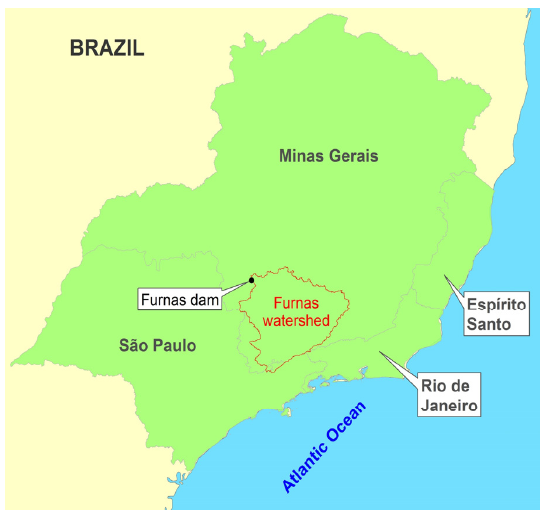
Figure 2. Furnas watershed, location of its dam, and states that form part of the Southeast Region of Brazil The reservoir covers 1,406.26 km², representing 2.7% of the watershed, and holds 22.6 billion m³ of water. The hydroelectric power plant has a net falling height (h) of 94.1 m (Furtado, 1965) and a water flow (Q) of 678 m³ s -1 (ANA, 2005). It has eight 152 MW generators, accounting for an installed capacity of 1,216 MW. Its reservoir intercepts 31 of the 203 municipalities in the watershed (Fig. 3).